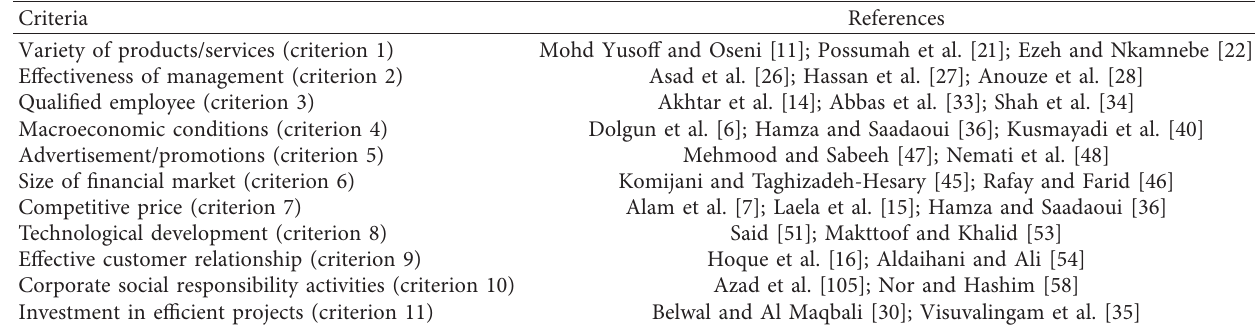
Table 1: The details of criteria.